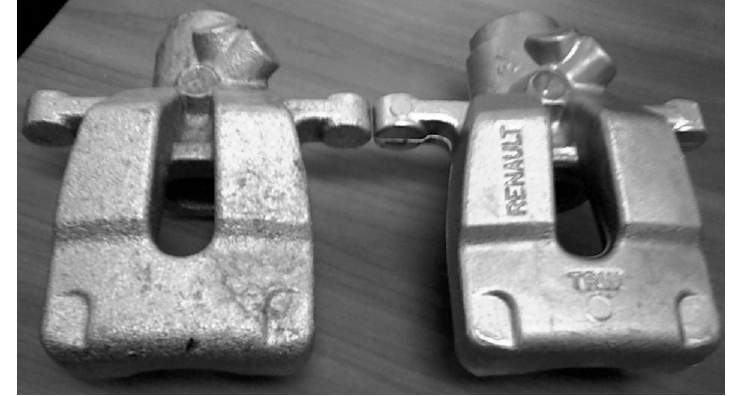
Fig. 4. Comparison of the surface aspect of a caliper from a RP mould (left) and from a metallic mould.